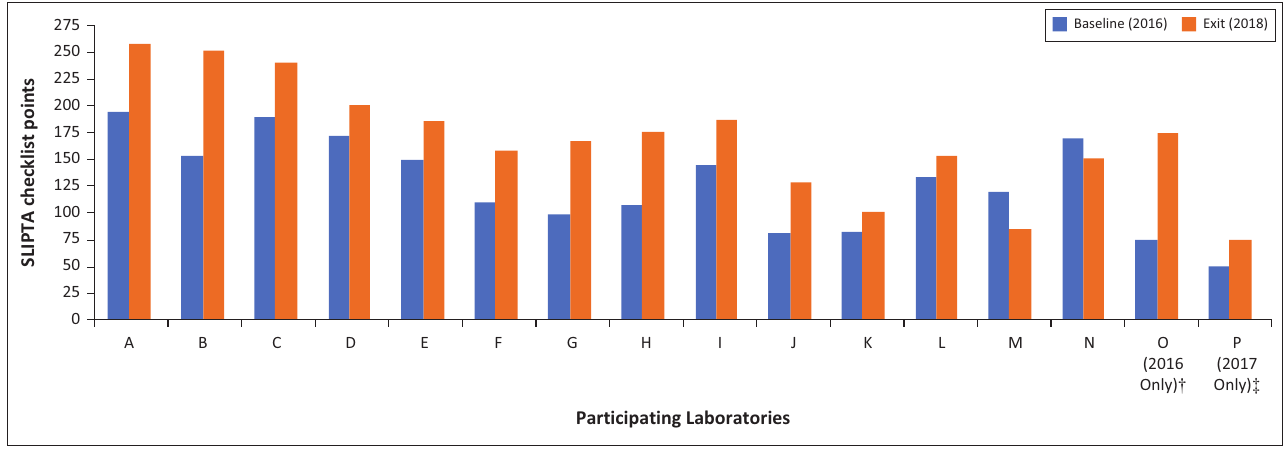
SLIPTA, Stepwise Laboratory Improvement Process Towards Accreditation. † , 2016 only; ‡ , 2017 only. FIGURE 2: Changes in laboratory audit scores before (2016) and after (2018) the Laboratory leadership and management programme in Zambia, 2016-2018. Participants and representatives from the Ministry of Health conducted baseline Stepwise Laboratory Improvement Program Towards Accreditation audits of each laboratory at the beginning (2016) and end of the programme (2018). Audit scores are shown as whole numbers with a maximum score of 275